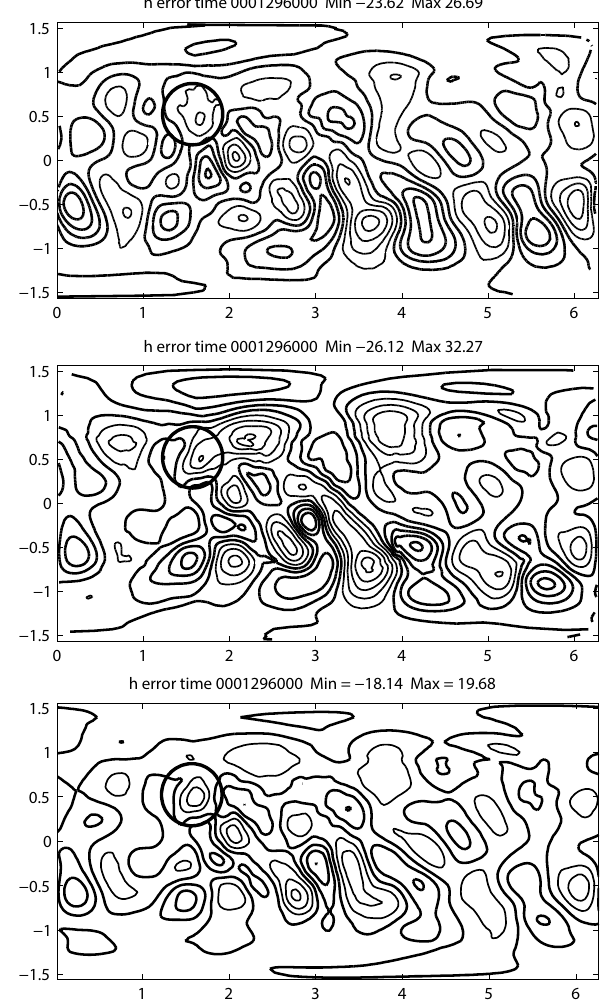
Figure 6. Height error at day 15 of the isolated mountain test case for the mimetic finite volume model on a hexagonal grid of 10242 cells (top), the mimetic finite volume model on a cubed-sphere grid of 13824 cells (middle), and for ENDGame on a longitude–latitude grid of 160 × 80 cells (bottom). The contour interval is 6m and zero and negative contours are bold. The bold circle indicates the loca- tion of the mountain centred at coordinates (π/ 2 ,π/ 6 ) .